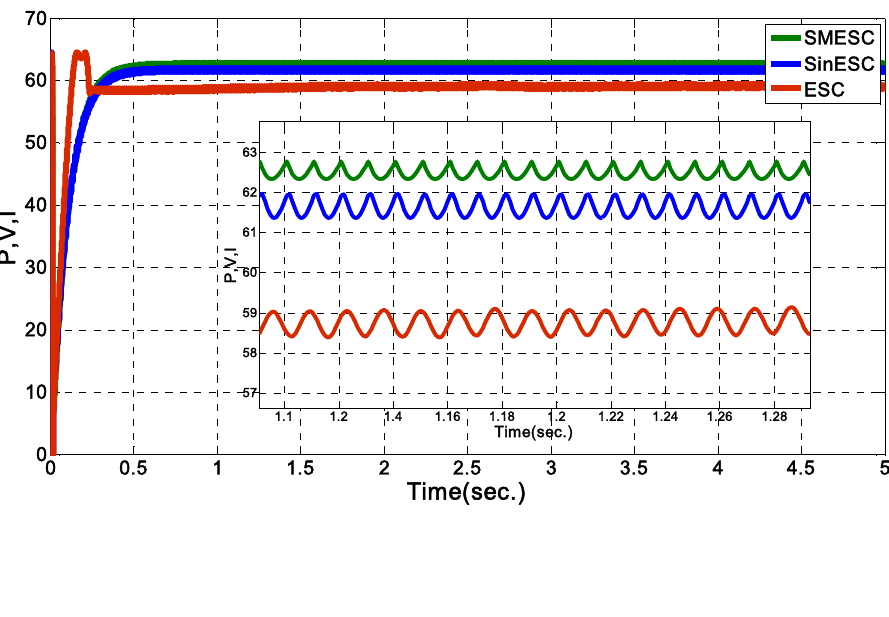
Figure 18. Output power comparison among ESC, SinESC and